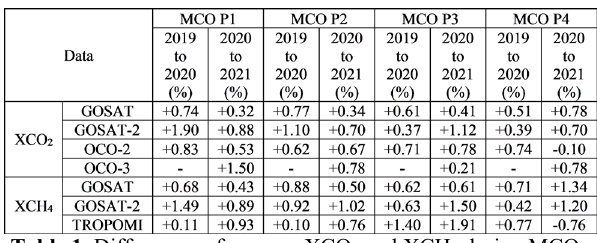
Table 1. Differences of average XCO 2 and XCH 4 during MCO periods from 2019 to 2021.